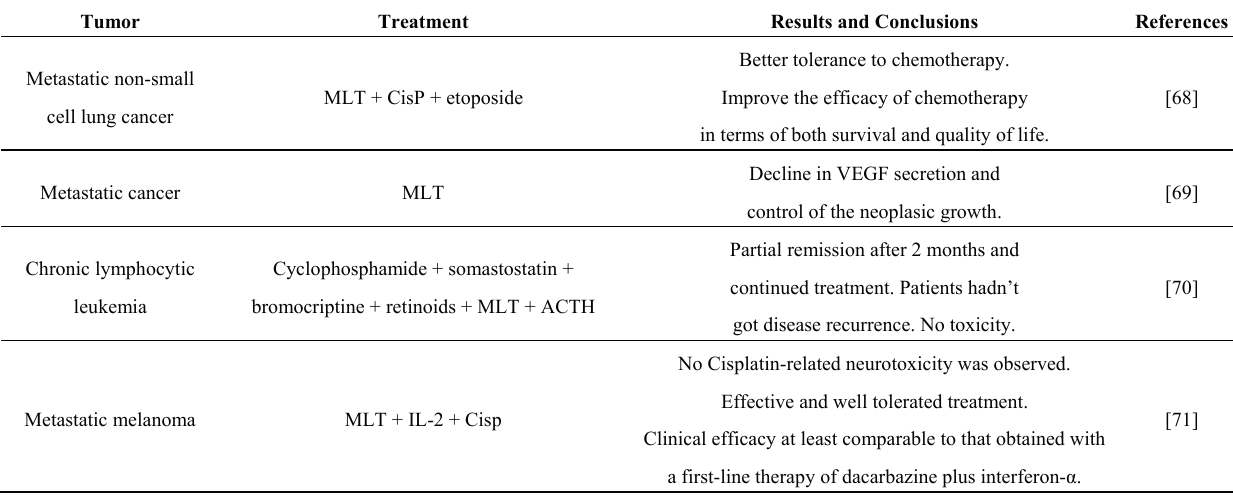
Table 1. Clinical trials that have tested the potential role of MLT as an antitumoral or as adjuvant in cancer